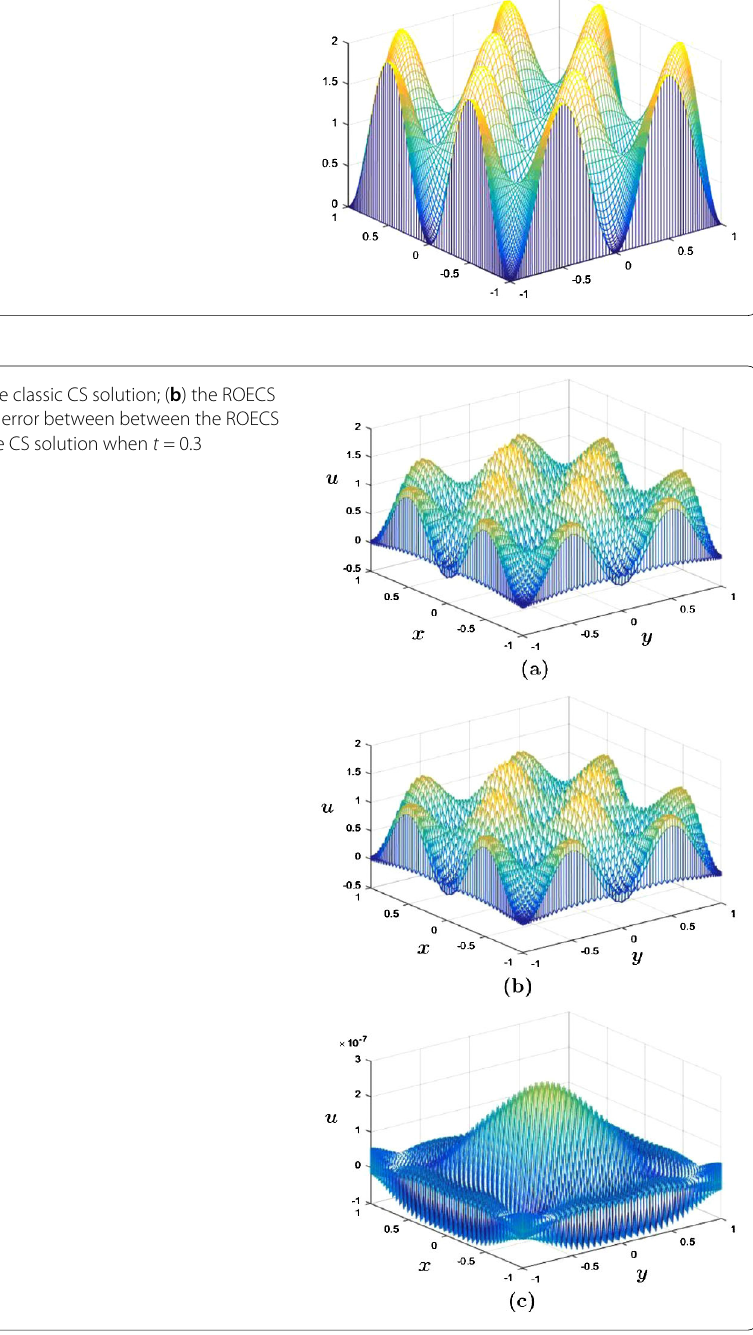
Figure 1 Initial value function when t = 0